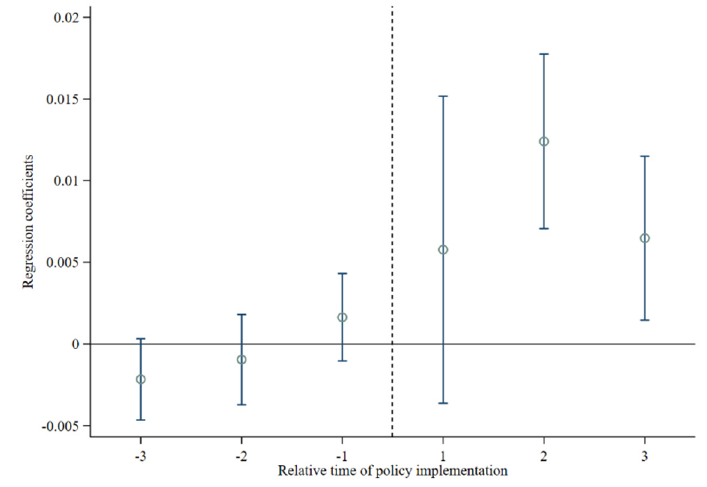
Figure 2. Parallel trend test results. Note: the horizontal axis represents the relative time point of food safety demonstration city creation. The vertical axis represents the regression coefficient of food safety demonstration city creation on agricultural development under the 95% confidence interval.